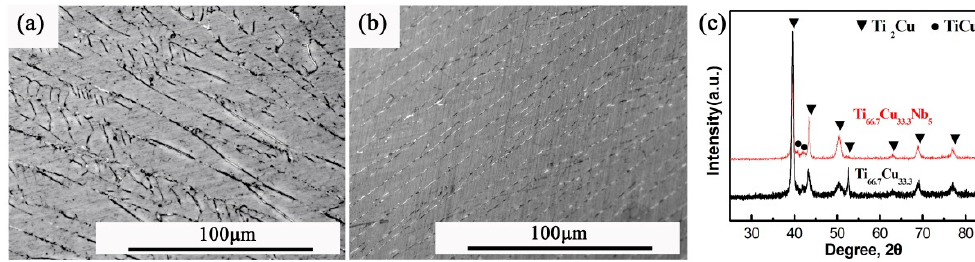
Figure 4. Microstructures of the Ti 66.7 Cu 33.3 (a), Ti 61.7 Cu 33.3 Nb 5 (b) alloys and their x-ray diffraction (XRD) patterns (c).